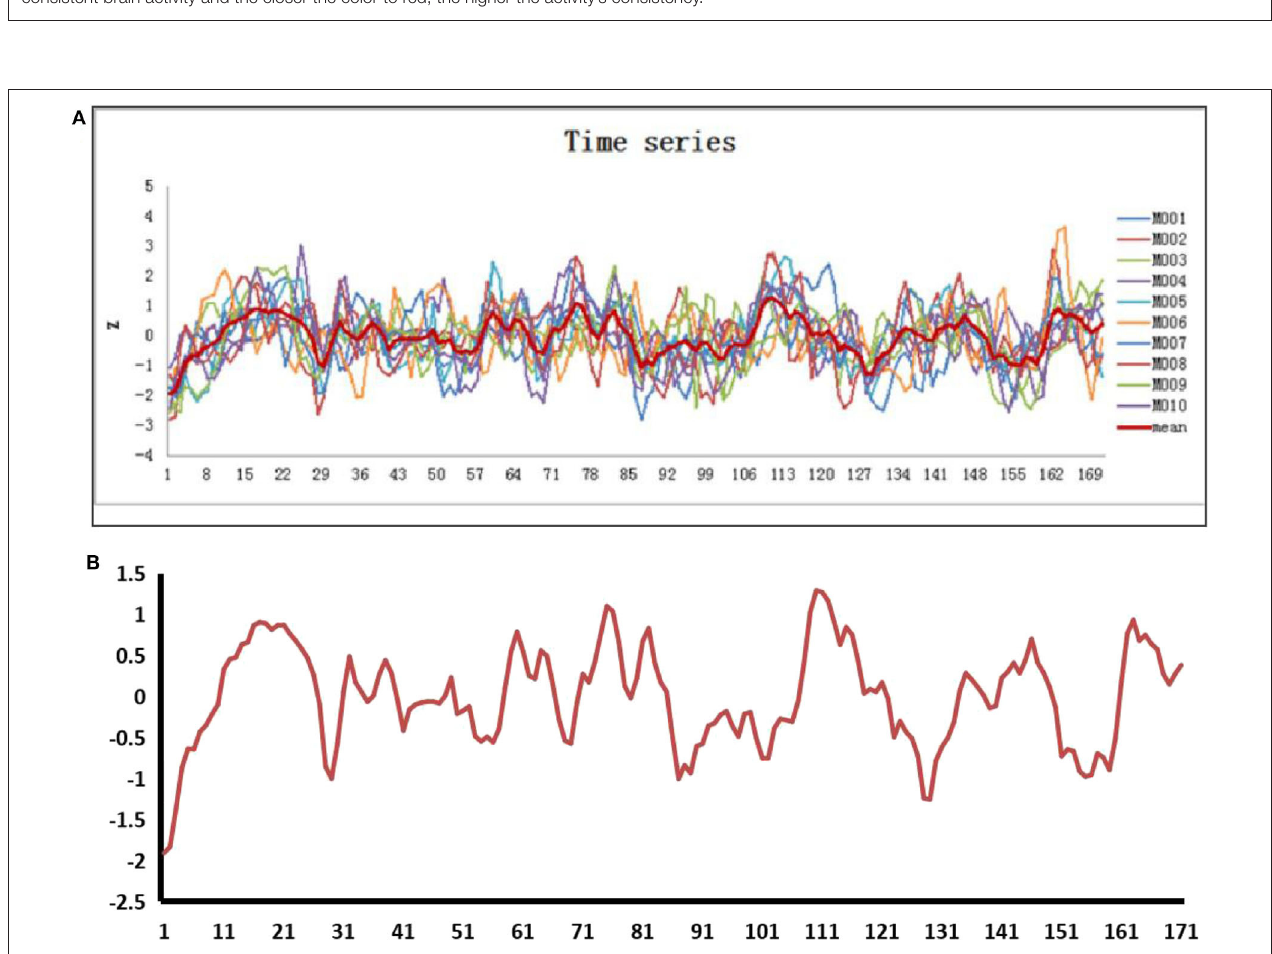
FIGURE 6 | (A) The whole-brain activity signals of ten participants while watching Psycho clip. (B) Average whole-brain activity signal of participants while watching Psycho clip.